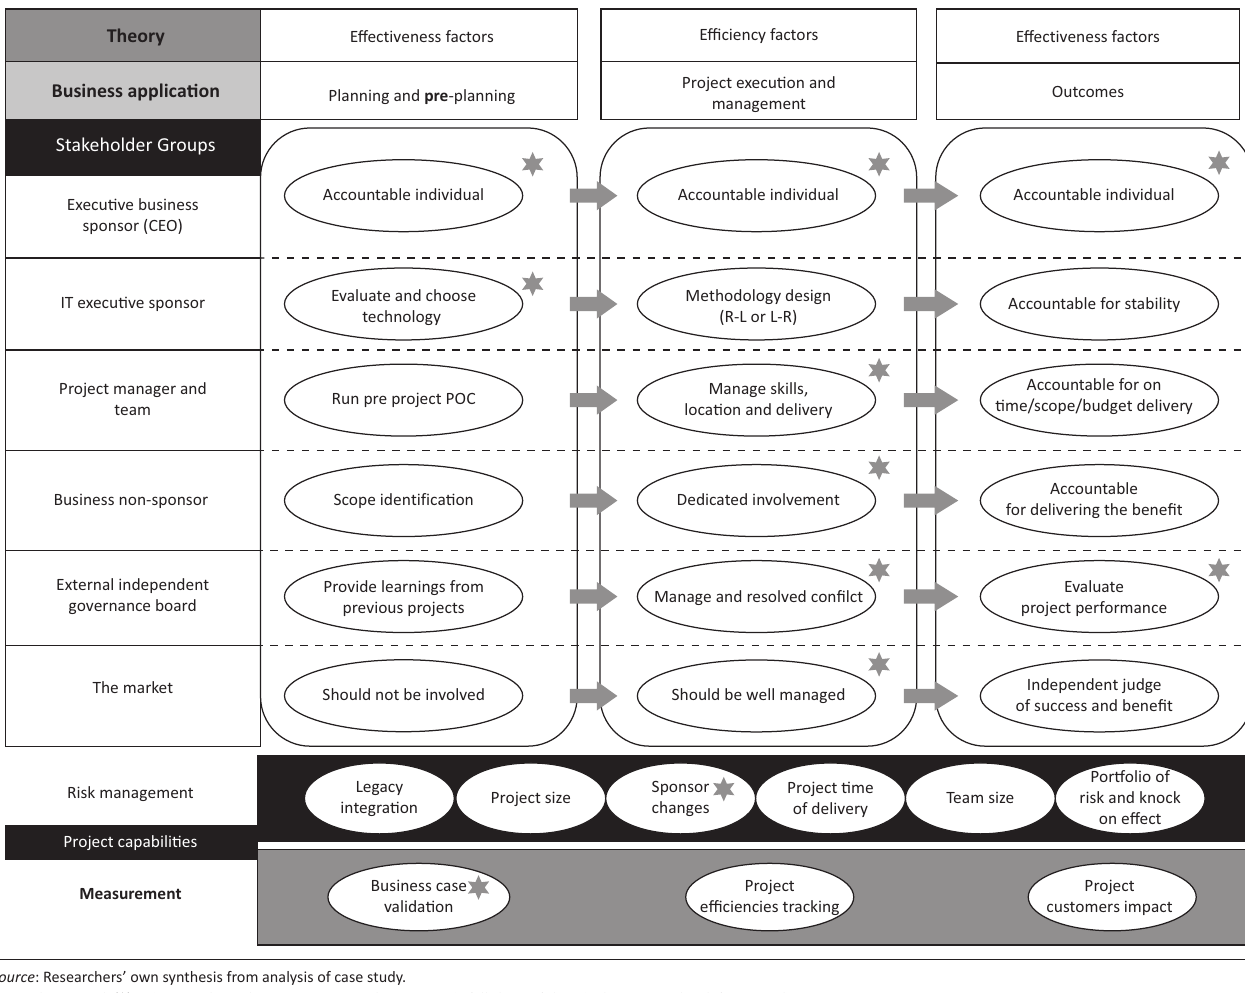
FIGURE 4: Holistic conceptual task framework for project success, based on synthesis from case study